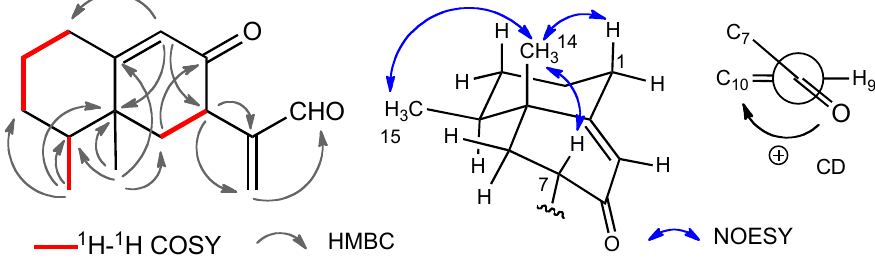
Figure 2. Selected 2D correlations and the sign of the CD for compound 1 .